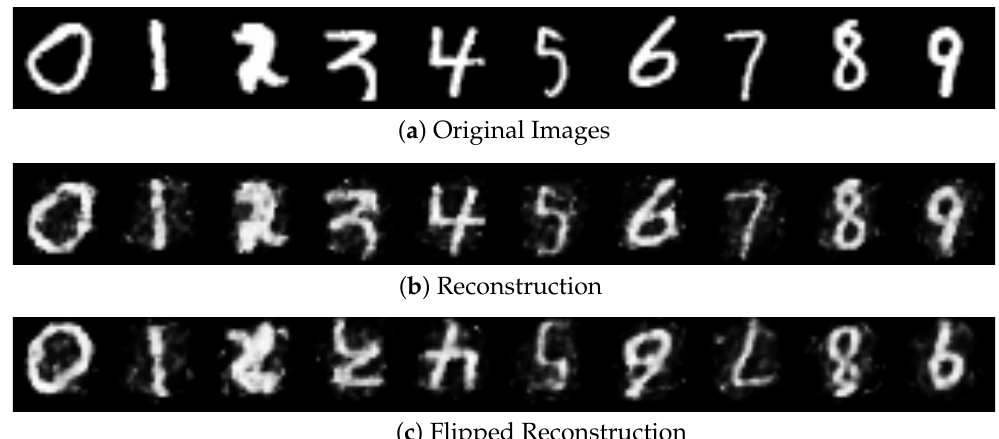
Figure 2. Examples of the reconstruction results on MNIST with an AE trained by the LAC. LAC for Convolutional AE (CAE)